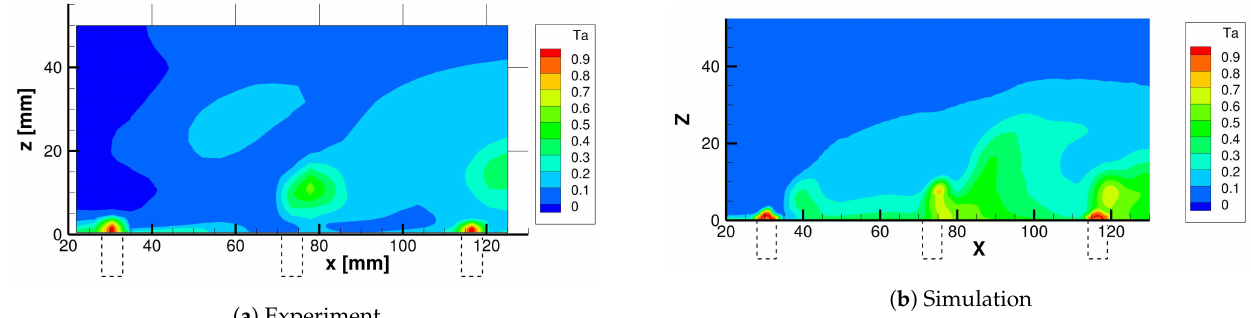
Figure 22. Experimental and numerical non-dimensional temperature field ( Y = − 61.15 mm plane).